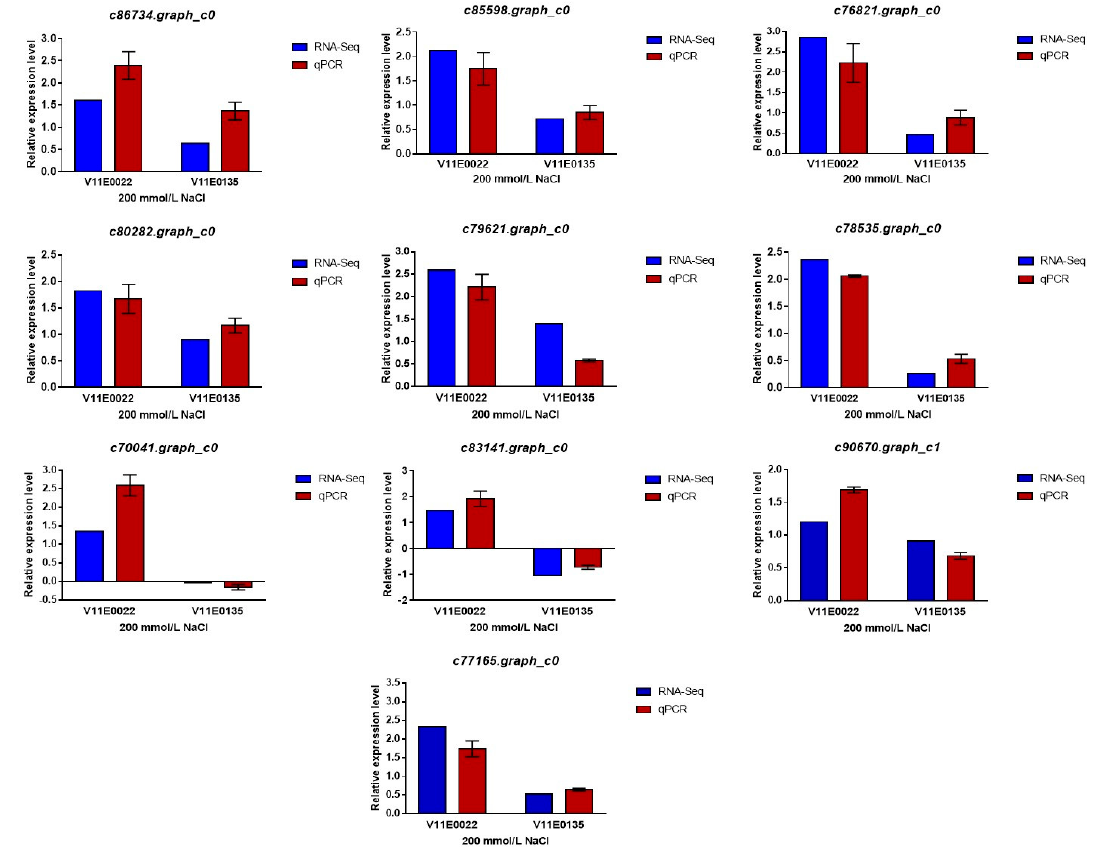
Figure 9. qRT-PCR analyses of DEGs responses of two water dropwort cultivars to salt stress. The expression patterns of 10 candidate genes were measured by qRT-PCR and RNA-seq under salt stress treatment. Actin was used as internal control. The individual black bars, representing the qPCR data, are the means ± SD.